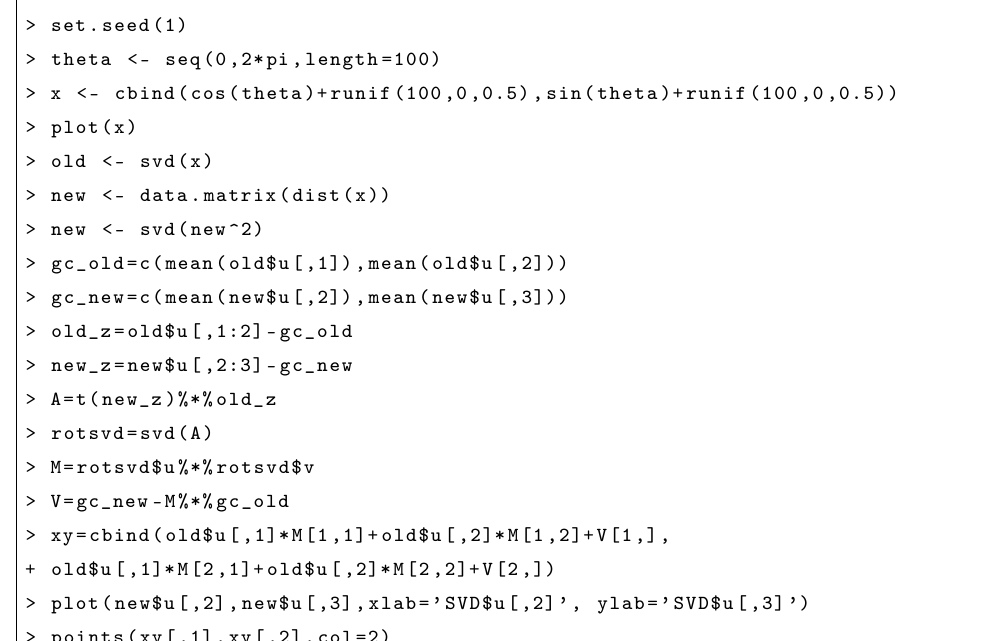
Table S3: Bio_rep2_DNAloop; Table S4: